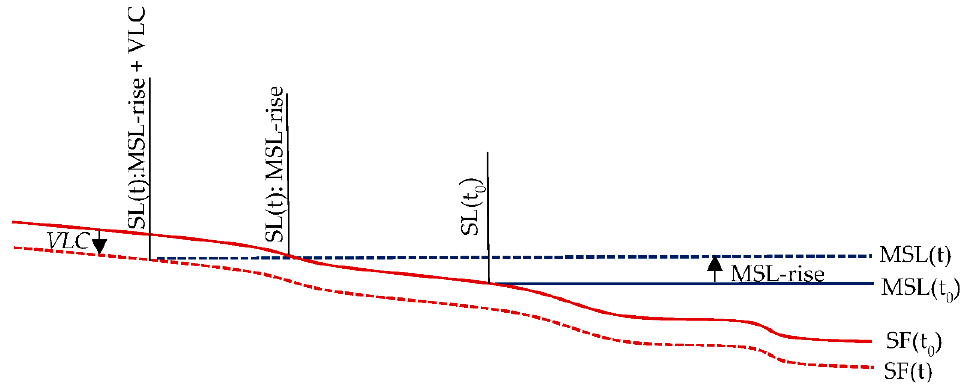
Figure 18. Shoreline ( SL ) retreat is either caused by sea level rise ( H SL (t) = H SL (t 0 ) − (t-t 0 )MSL trend ) or by a combination of sea level rise and land subsidence ( H SL (t) = H SL (t 0 ) − (t-t 0 )MSL trend − δ VLC (t) ).